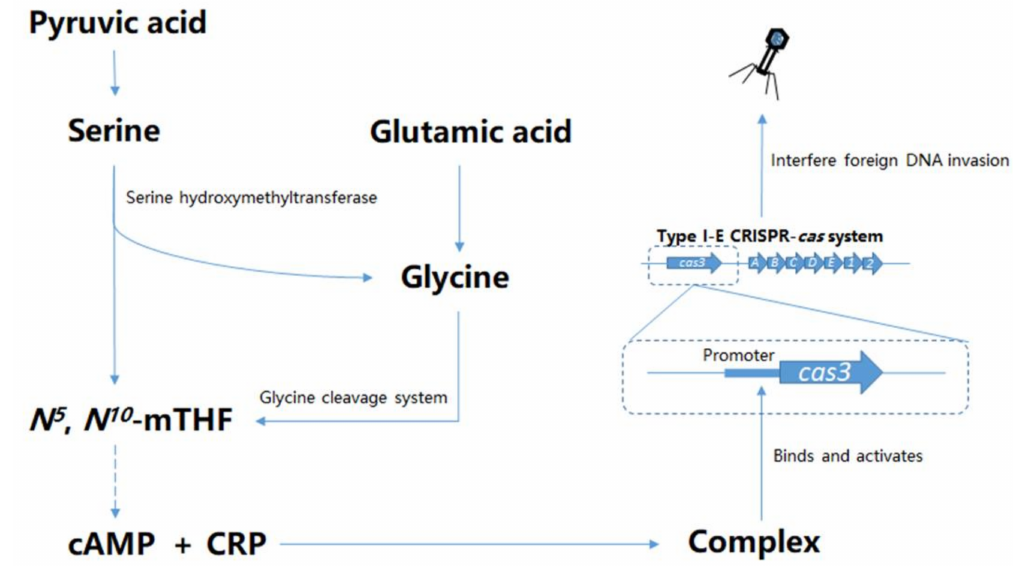
Figure 11. The proposed regulation model of the CRISPR / cas3 within E. coli . The N 5 , N 10 -mTHF is produced in both serine and glycine metabolism pathways. The disruption of GCS leads to a decrease in N 5 , N 10 -mTHF. Intracellular cAMP concentration correlates with N 5 , N 10 -mTHF production. Reduced cAMP weakens the binding ability of the CRP–cAMP complex, which is capable of activating cas3 expression by binding to the cas3 promoter. The altered cas3 expression a ff ects interference with invasive